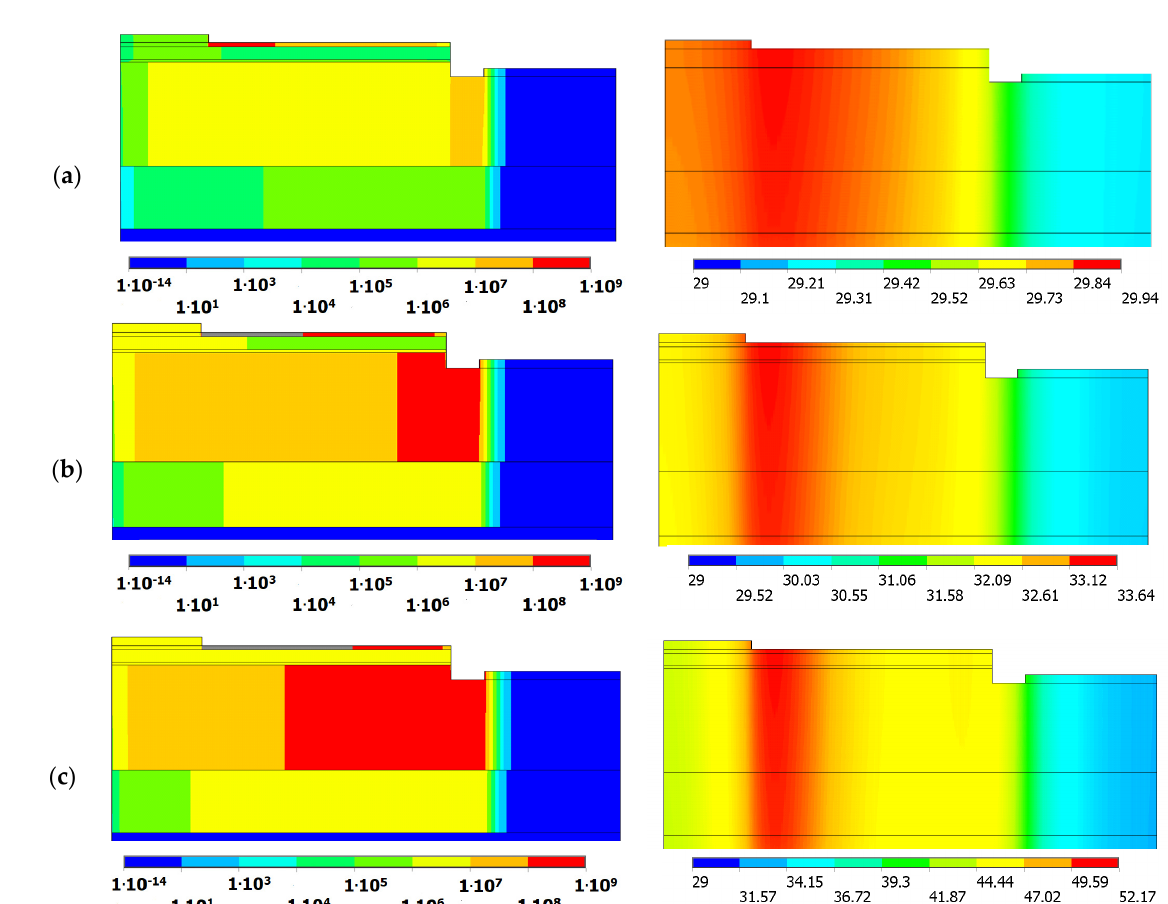
Figure 9. Current density ( left ) and temperature ( right ) distributions within the modelled preliminary structure for a forward bias of ( a ) 3.10 V, ( b ) 3.62 V, and ( c ) 4.87 V.